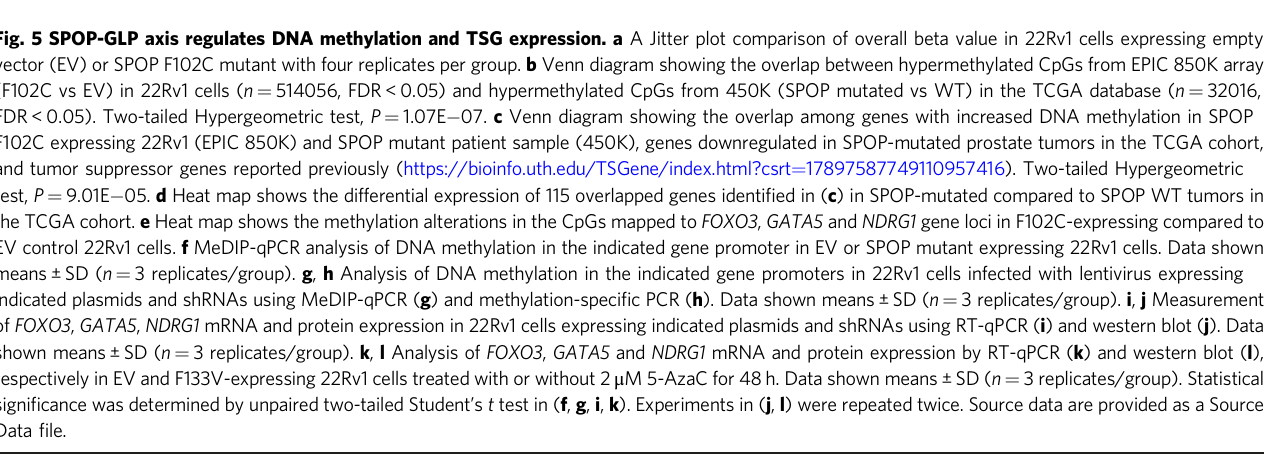
Fig. 5 SPOP-GLP axis regulates DNA methylation and TSG expression. a A Jitter plot comparison of overall beta value in 22Rv1 cells expressing empty vector (EV) or SPOP F102C mutant with four replicates per group. b Venn diagram showing the overlap between hypermethylated CpGs from EPIC 850K array (F102C vs EV) in 22Rv1 cells ( n = 514056, FDR<0.05) and hypermethylated CpGs from 450K (SPOP mutated vs WT) in the TCGA database ( n = 32016, FDR<0.05). Two-tailed Hypergeometric test, P = 1.07E − 07. c Venn diagram showing the overlap among genes with increased DNA methylation in SPOP F102C expressing 22Rv1 (EPIC 850K) and SPOP mutant patient sample (450K), genes downregulated in SPOP-mutated prostate tumors in the TCGA cohort, and tumor suppressor genes reported previously (https://bioinfo.uth.edu/TSGene/index.html?csrt = 17897587749110957416). Two-tailed Hypergeometric test, P = 9.01E − 05. d Heat map shows the differential expression of 115 overlapped genes identi fi ed in ( c ) in SPOP-mutated compared to SPOP WT tumors in the TCGA cohort. e Heat map shows the methylation alterations in the CpGs mapped to FOXO3 , GATA5 and NDRG1 gene loci in F102C-expressing compared to EV control 22Rv1 cells. f MeDIP-qPCR analysis of DNA methylation in the indicated gene promoter in EV or SPOP mutant expressing 22Rv1 cells. Data shown means±SD ( n = 3 replicates/group). g , h Analysis of DNA methylation in the indicated gene promoters in 22Rv1 cells infected with lentivirus expressing indicated plasmids and shRNAs using MeDIP-qPCR ( g ) and methylation-speci fi c PCR ( h ). Data shown means±SD ( n = 3 replicates/group). i , j Measurement of FOXO3 , GATA5 , NDRG1 mRNA and protein expression in 22Rv1 cells expressing indicated plasmids and shRNAs using RT-qPCR ( i ) and western blot ( j ). Data shown means±SD ( n = 3 replicates/group). k , l Analysis of FOXO3 , GATA5 and NDRG1 mRNA and protein expression by RT-qPCR ( k ) and western blot ( l ), respectively in EV and F133V-expressing 22Rv1 cells treated with or without 2 μ M 5-AzaC for 48h. Data shown means±SD ( n = 3 replicates/group). Statistical signi fi cance was determined by unpaired two-tailed Student ’ s t test in ( f , g , i , k ). Experiments in ( j , l ) were repeated twice. Source data are provided as a